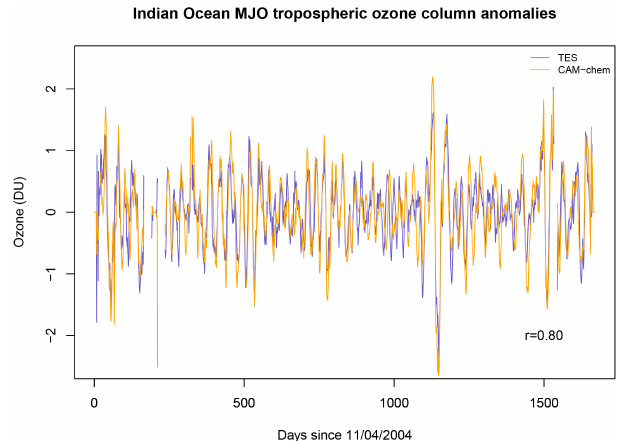
Figure 4. Time series of the 30–60-day bandpass filtered deseason- alized tropospheric ozone column anomalies (in DU) from TES and CAM-chem, averaged over the Indian Ocean (45–100 ◦ E, 10 ◦ S– 10 ◦